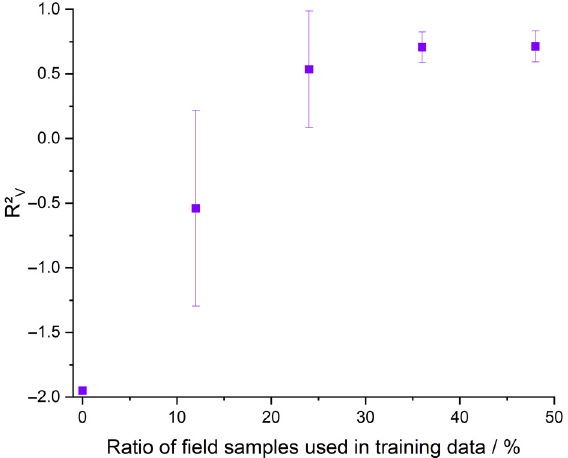
Figure 10. Evolution of the R² V of the validation data with increasing proportion of randomly chosen field samples in the training data for the Polish samples measured on the Echelle (purple). This process was performed five times.